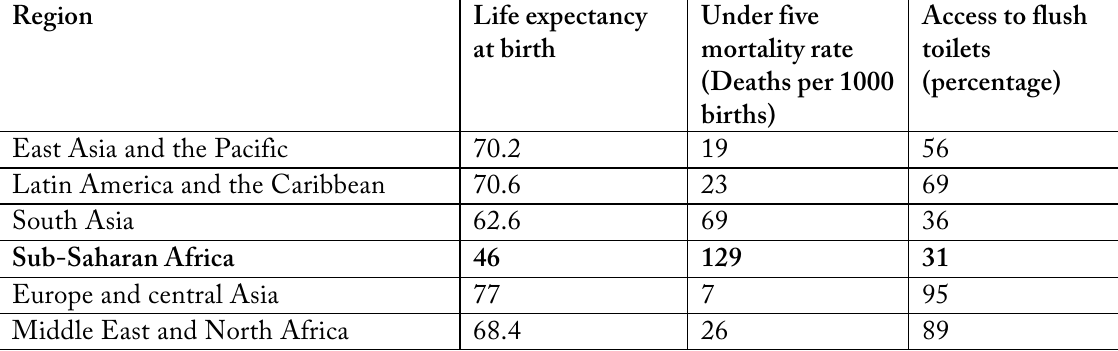
Table 2: Selected social and environmental development indicators. Source: Millennium development goals report 2011:25 and